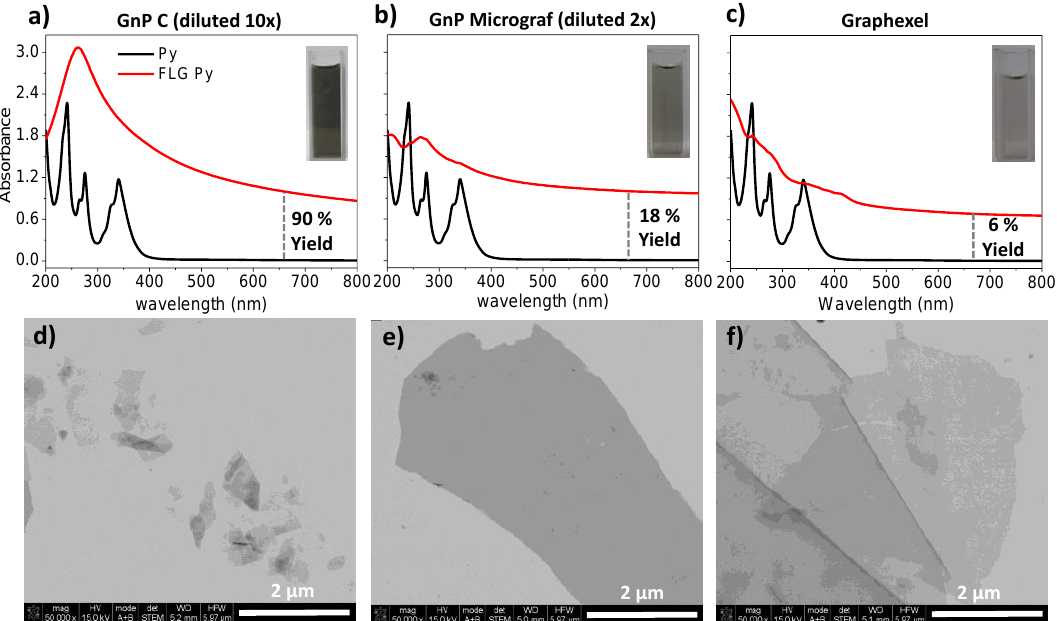
Figure 2. ( a – c ) UV-visible spectra of the few-layer graphene (FLG) suspensions obtained from GnPC, Micrograf, and Graphexel starting materials, respectively; ( d – f ) Scanning transmission electron microscopy images of the FLG GnPC, FLG Micrograf, and FLG Graphexel, respectively.